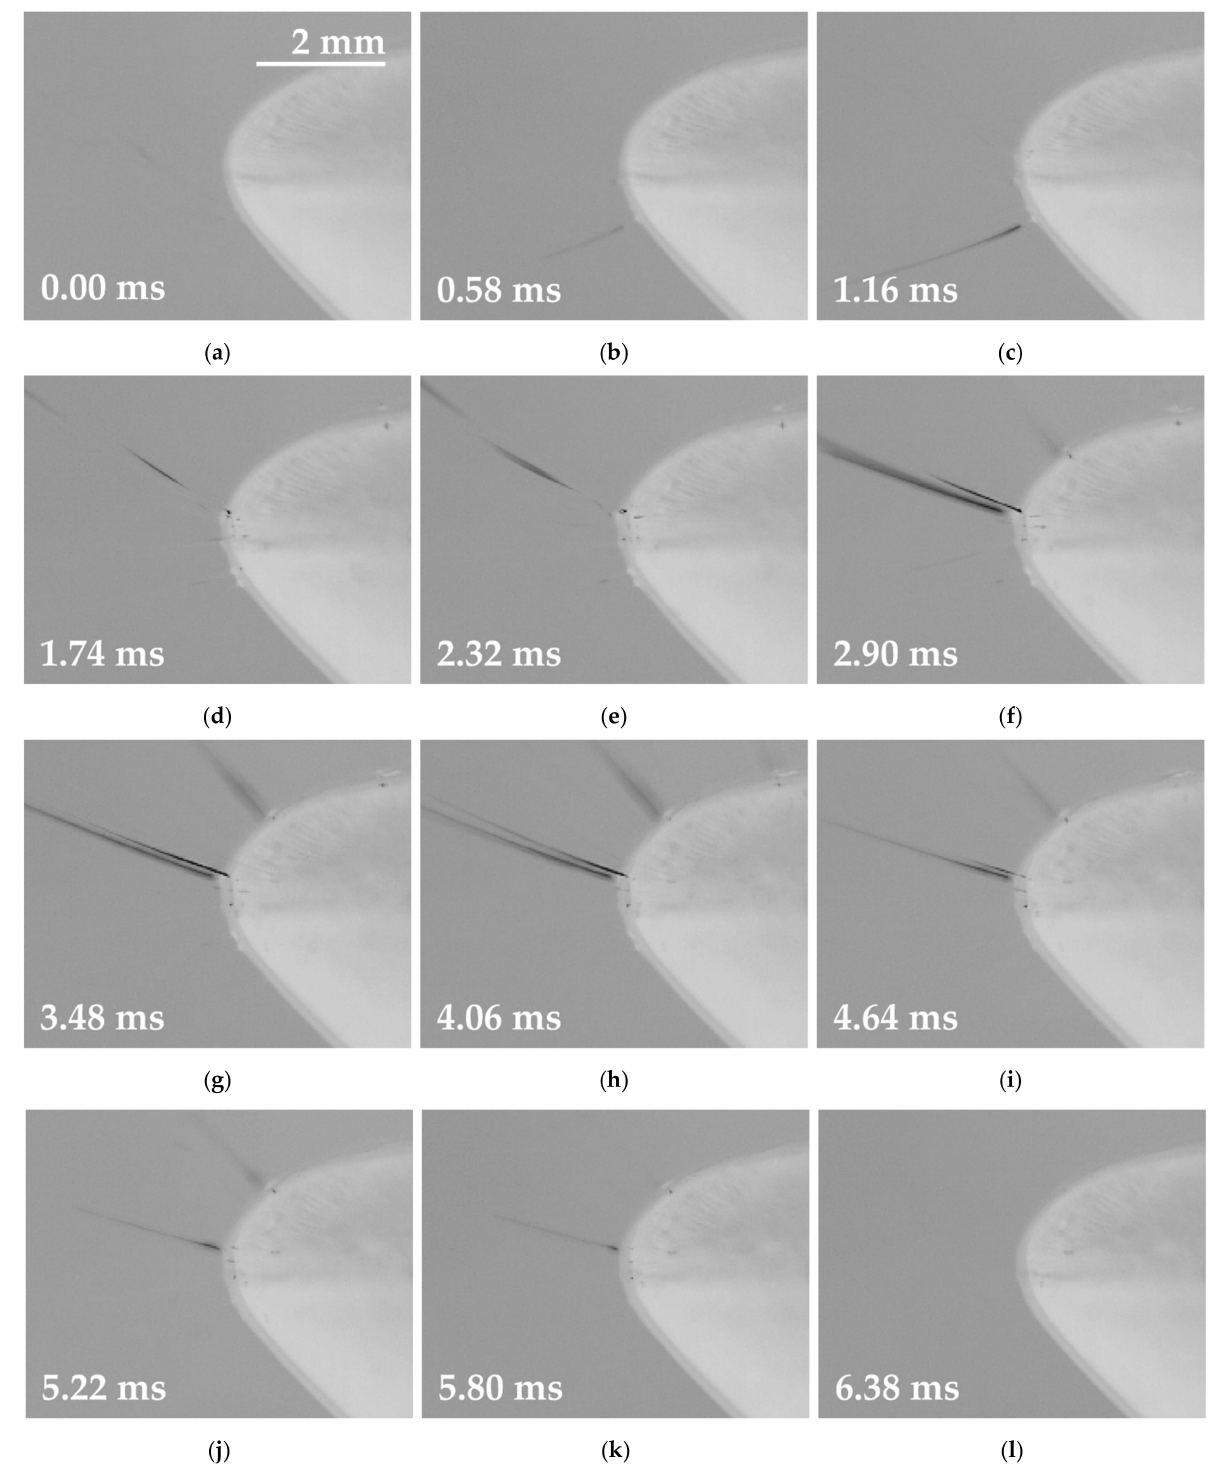
Figure 4. A frame sequence showing the accelerated electrospinning of the modified PA 6 solution driven by the sinus wave signal. The electrode with no instability ( a ) generated the first Taylor cone ( b , c ), followed by the creation of multiple cones ( d , e ). The efficient spinning area was characterized by a high number of thicker cones ( f – h ). The cones slowly diminished ( i , j ). The last jet ( k ) collapsed, thus leading to the initial state ( l ), which lasted for the rest of the half-wave (around 3.62